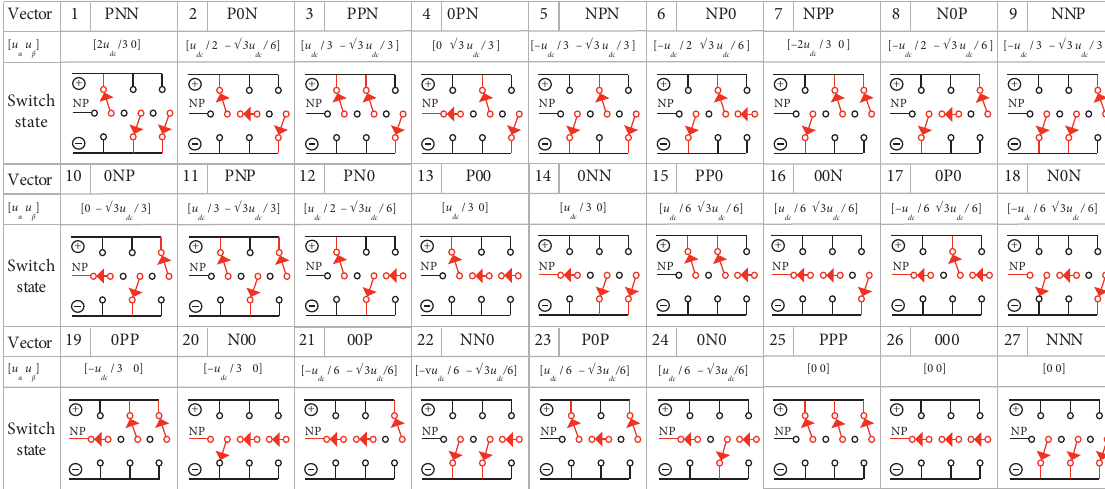
Figure 3: Control set definition for a T-type three-level